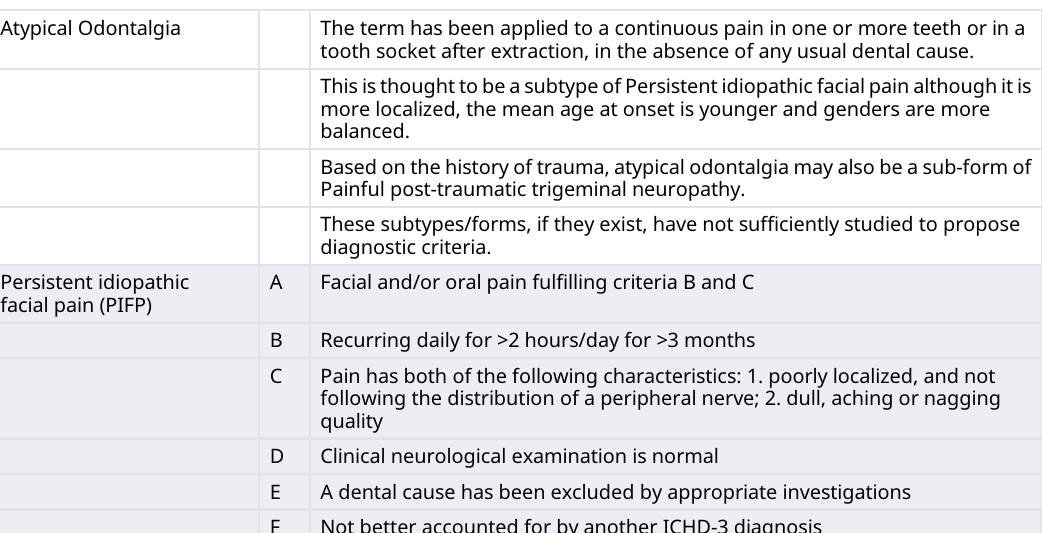
Table 1. Diagnostic criteria for the diagnosis of Atypical Odontalgia and Persistent Idiopathic Facial Pain according to the International Classification of Headache Disorders (ICHD-3 classification 23 ). Atypical